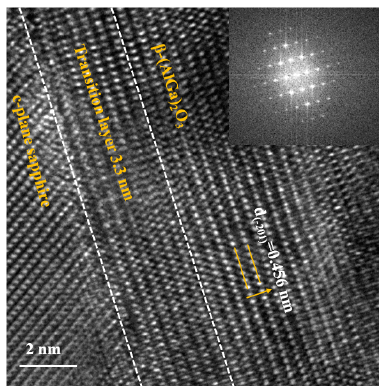
Figure 8. The HRTEM image of β -(Al x Ga 1 − x ) 2 O 3 film on sapphire substrate.